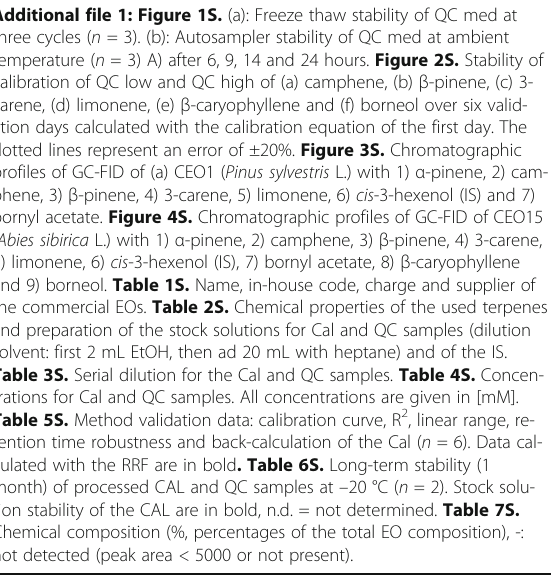
Additional file 1: Figure 1S. (a): Freeze thaw stability of QC med at three cycles ( n = 3). (b): Autosampler stability of QC med at ambient temperature ( n = 3) A) after 6, 9, 14 and 24 hours. Figure 2S. Stability of calibration of QC low and QC high of (a) camphene, (b) β -pinene, (c) 3- carene, (d) limonene, (e) β -caryophyllene and (f) borneol over six valid- ation days calculated with the calibration equation of the first day. The dotted lines represent an error of ±20%. Figure 3S. Chromatographic profiles of GC-FID of (a) CEO1 ( Pinus sylvestris L.) with 1) α -pinene, 2) cam-